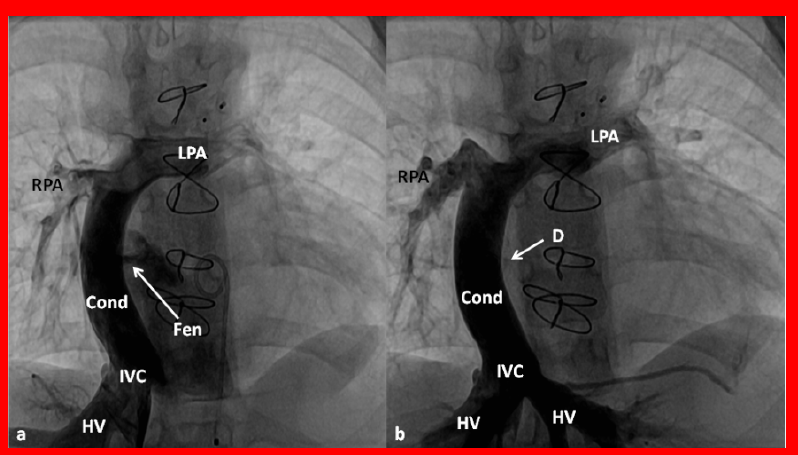
Figure 57. Selected cineangiographic frames in antero–posterior view, demonstrating Stage IIIA of the Fontan procedure: diverting the inferior vena caval (IVC) flow into the pulmonary arteries via a nonvalve conduit (Cond). Note the fenestration (Fen) shown by the arrow in ( a ) The Fen is closed with an Amplatzer device (D), shown by the arrow in ( b ) (Stage IIIB). HV, hepatic veins; LPA, left pulmonary artery; RPA, right pulmonary artery. Reproduced from Reference [36].